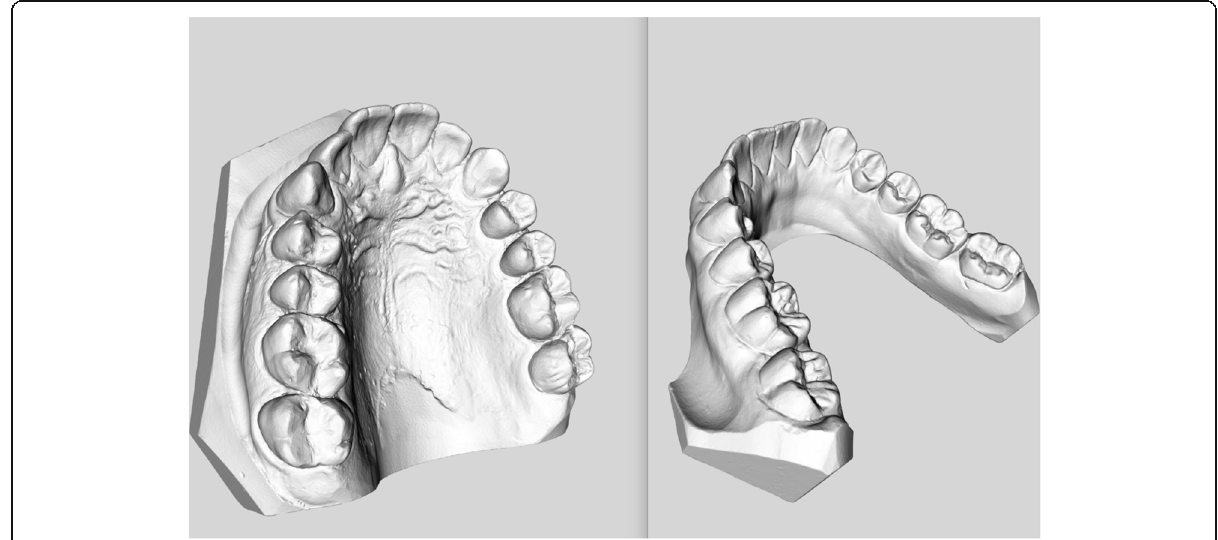
Fig. 1 Illustrative example of the 3D images of jaws models by